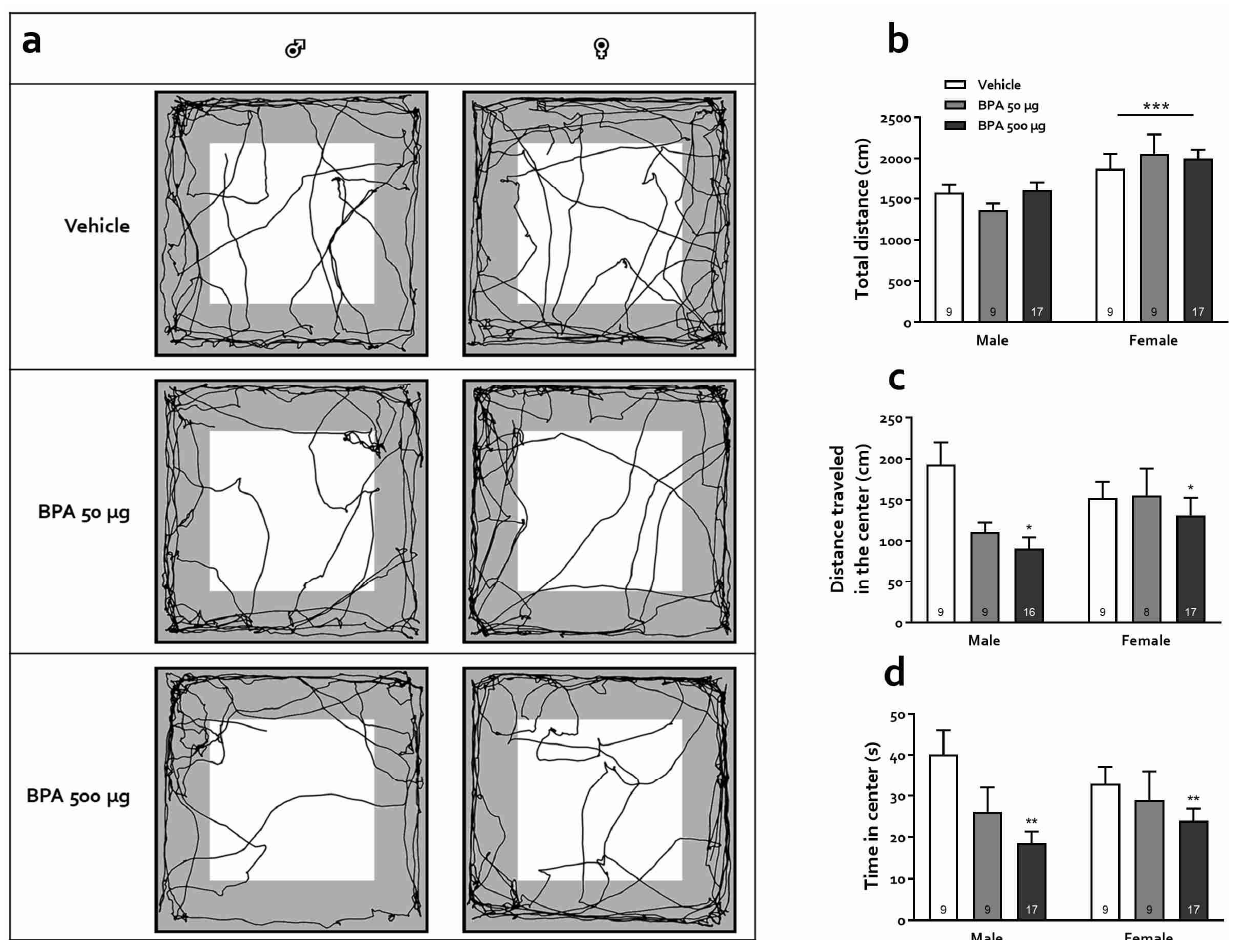
Figure 3. Effects of BPA on the OFT. ( a ) Representative trajectory for each treatment; the gray area corresponds to the periphery and the white area to the center of the arena. ( b ) Time spent in the center of the arena in male and female rats. ( c ) Distance traveled in the center of arena, and ( d ) Total distance traveled. Each bar represents the mean ± SEM. Numbers within bars indicate animals per group. *: p < 0.05 and **: p < 0.01 vs. pooled vehicle; ***: p < 0.001 vs. males.